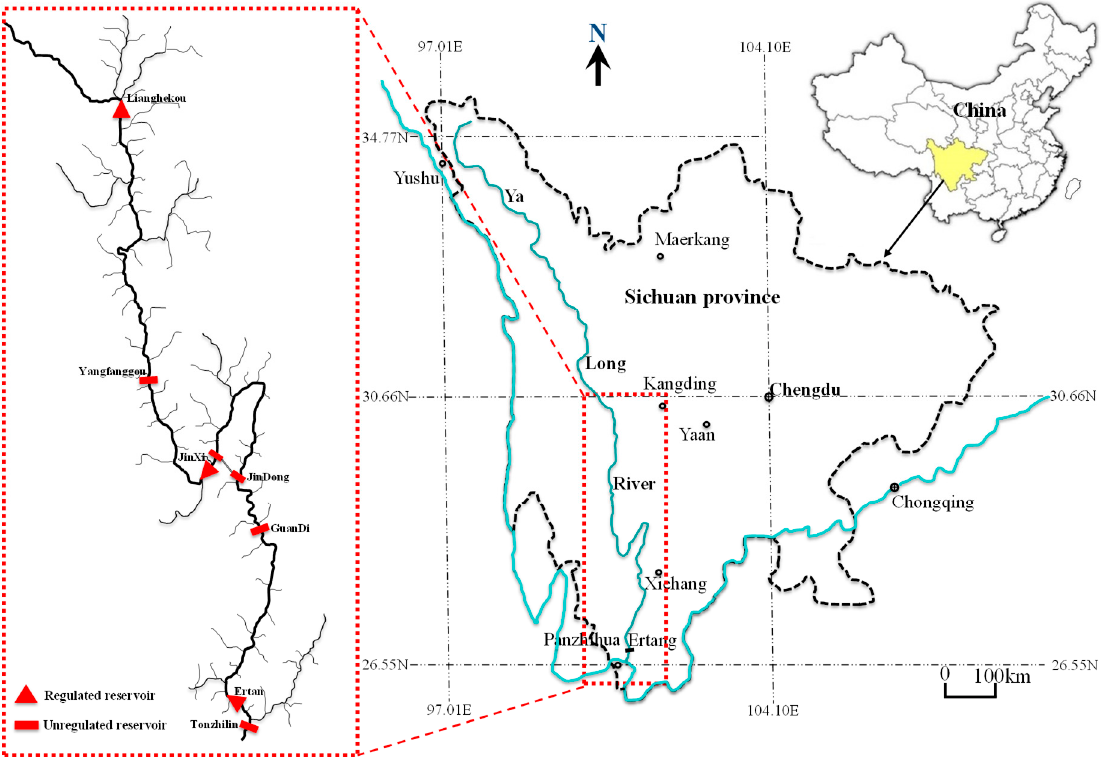
Figure 7. Geographic locations of Yalong River cascade reservoirs.